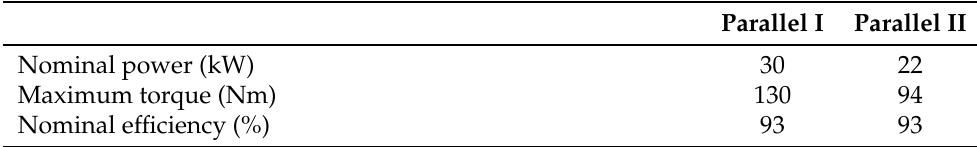
Table 4. Main properties of the EM adopted by the parallel architectures.